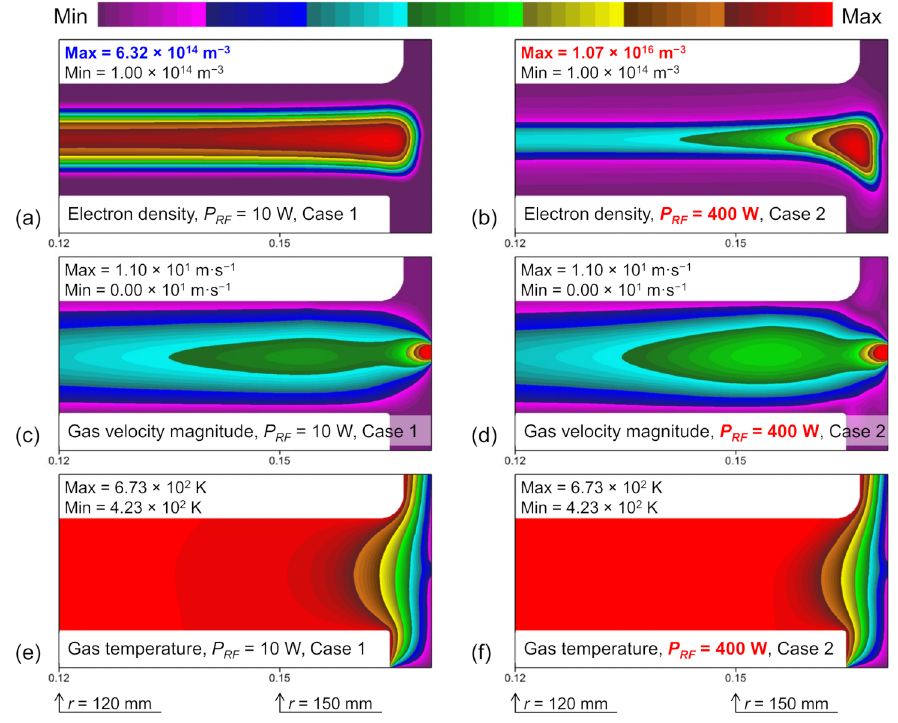
Figure 2. Contour plots of the spatial profiles of the time-averaged electron density (m − 3 ) for ( a ) Case 1 ( P RF = 10 W) and ( b ) Case 2 ( P RF = 400 W) for r ≥ 120 mm. Contour plots for the spatial profiles of the gas velocity (m · s − 1 ) for ( c ) Case 1 ( P RF = 10 W) and ( d ) Case 2 ( P RF = 400 W) for r ≥ 120 mm. Contour plots for the spatial profiles of the gas temperature (K) for ( e ) Case 1 ( P RF = 10 W) and ( f ) Case 2 ( P RF = 400 W) for r ≥ 120 mm. The profiles are radially uniform for r < 120